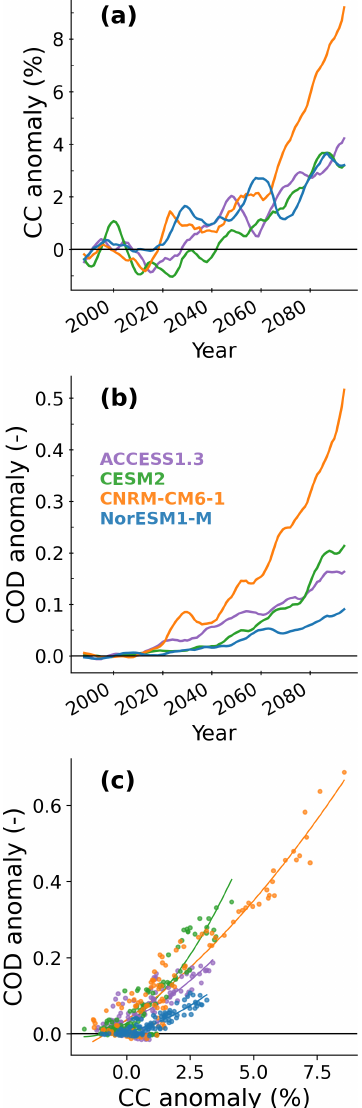
Figure 4. Changes in mean summer cloud cover (%) (a) , mean summer cloud optical depth (–) (b) , and changes in mean summer cloud optical depth (–) as a function of changes in mean summer cloud cover (%) (c) projected by MAR forced by ACCESS1.3 (pur- ple), CESM2 (green), CNRM-CM6-1 (orange), and NorESM1-M (blue) compared to the present summer climate (1981–2010) over the ice shelves of the west Antarctic sector. Values are averaged us- ing a 10-year rolling